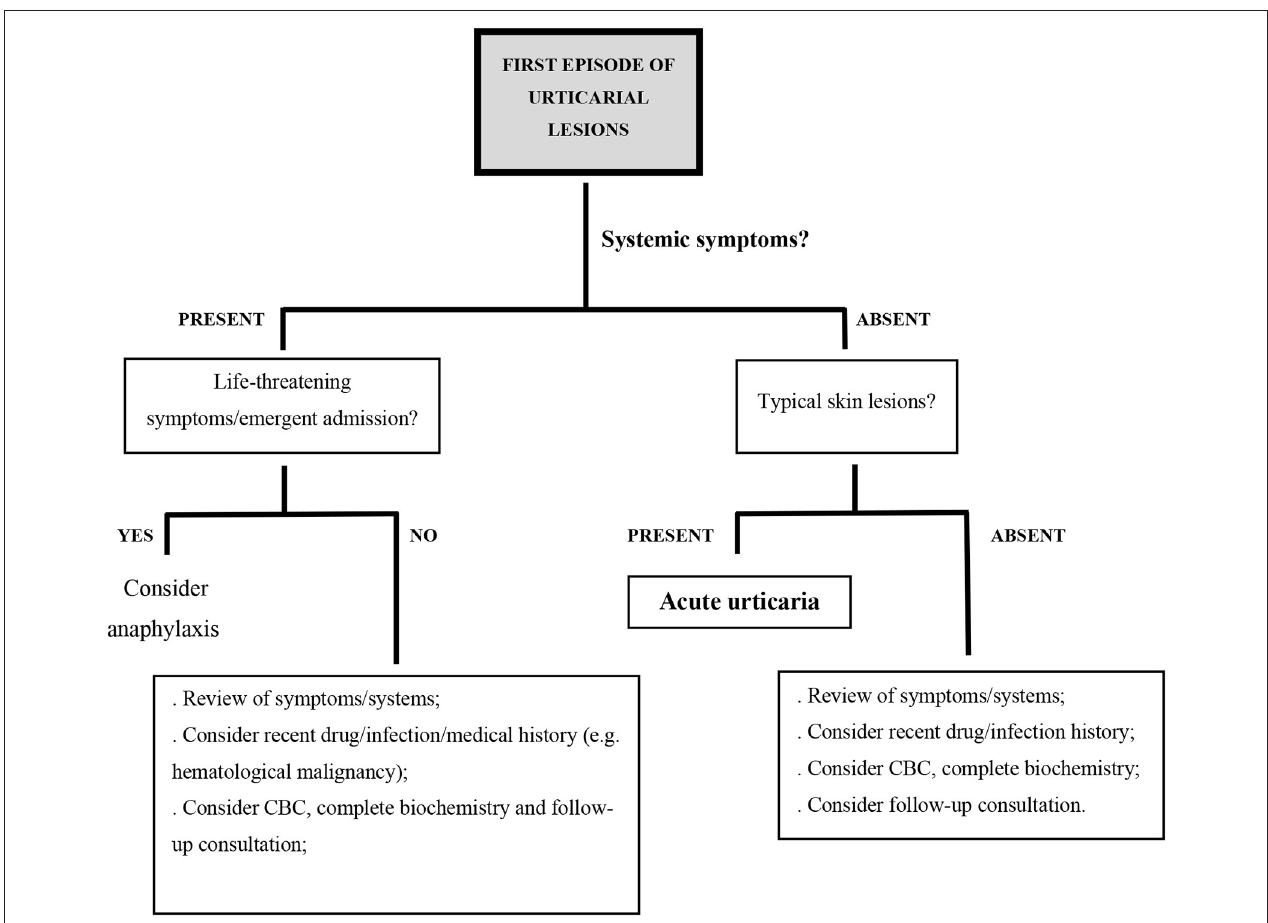
FIGURE 1 | Proposed diagnostic algorithm in the setting of acute urticarial lesions; CBC, complete blood